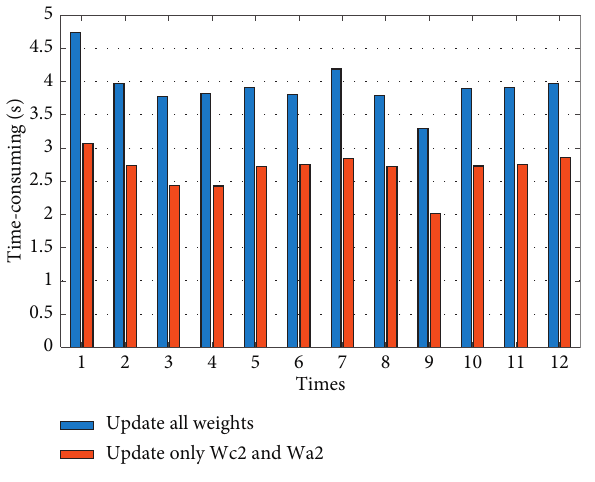
Figure 14: Comparison of time consumption in 12 group simulations.